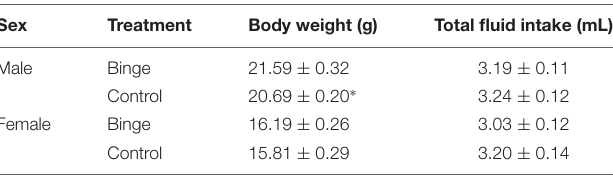
TABLE 1 | Body weight and total fluid intake during the Scheduled High Alcohol Consumption